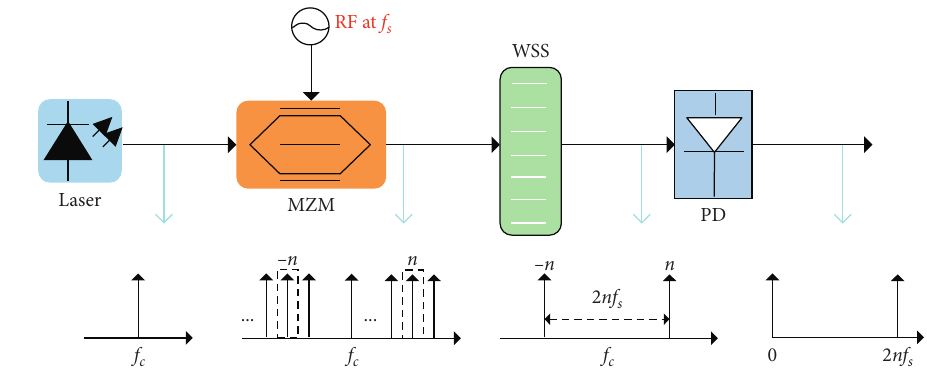
Figure 8: Multifrequency vector millimeter-wave generation